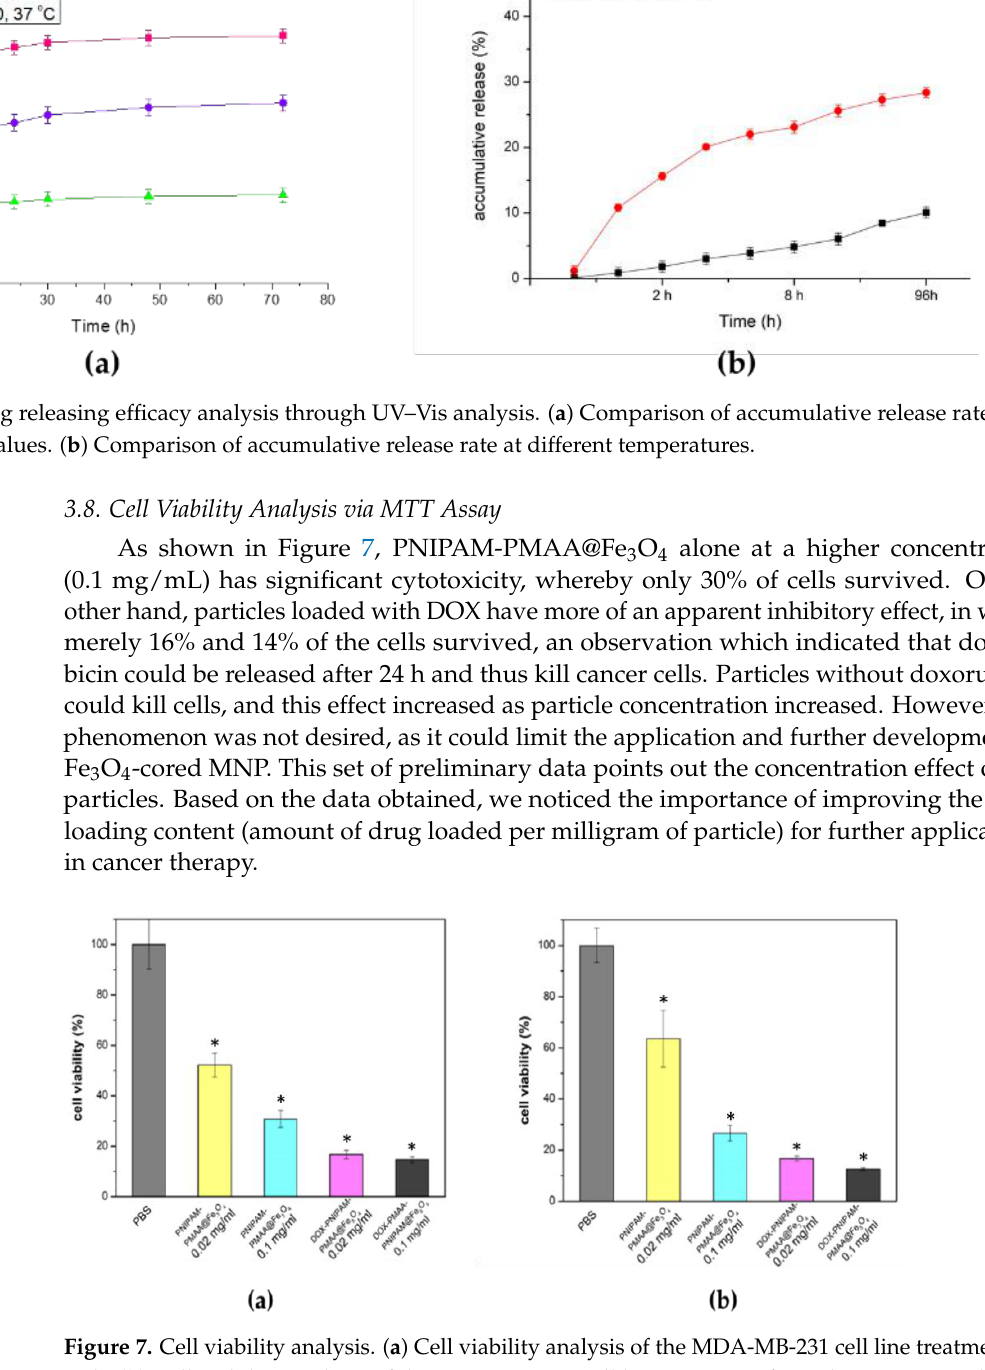
10 of 15 Figure 5. ( a ) Fluorescence emission spectrum of DOX-loaded particle (DOX-PNIPAM-PMAA @Fe 3 O 4 ) suspension (excitation 480 nm); ( b ) UV–Vis absorption spectrum of DOX-PNIPAM-PMAA@Fe 3 O 4. 3.7. In Vitro Drug Releasing Efficacy Analysis All samples were collected and subjected to UV-Vis absorption analysis. The results are summarized in Figure 6a. As shown in Figure 6, under extreme reaction conditions (pH 2.5), DOX was released swiftly in the first 30 min, and the accumulative release percentage reached nearly 59% after 72 h of treatment. In the neutral reaction condition (pH 7.0), the DOX-releasing efficacy did not seem optimal, which only reached 21% of all the drug loaded. Afterwards, in the modest acidic reaction environment (pH 5.0), DOX releasing had the most optimal results. Under the condition of pH 5.0, the cumulative release percentage (43%) could not compete with the result of pH 2.5, but it had relatively stable and mild releasing rates, which was consistent with our expectation that in the tumor microenvironment (at around pH 5.0–6.5), acidic conditions could